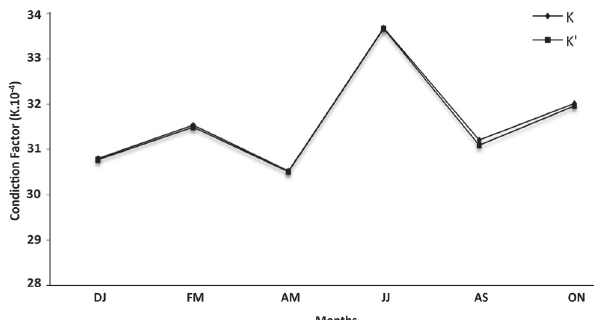
Fig. 7. Bimonthly variations in the total ( K ) and somatic ( K´ ) condition factors for Loricariichthys melanocheilus males in the rio Ibicuí, Rio Grande do Sul. (DJ = December/January, FM = February/March, AM = April/May; JJ = June/July, AS = August/September, ON = October/November).